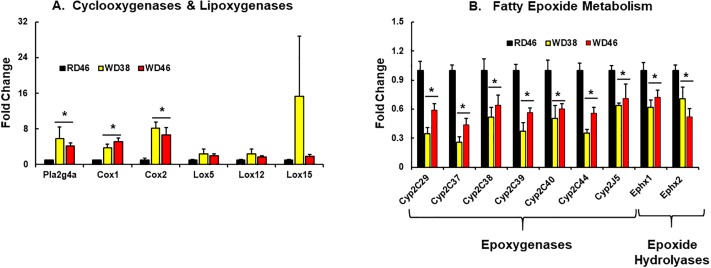
Western diet effects on hepatic expression of enzymes linked to oxylipin metabolism: Cyclooxygenases and lipoxygenases (A) and enzymes involved in fatty epoxide metabolism (B). Transcript abundance was quantified as described above. Results are expressed as mRNA abundance, as fold change; mean ± SEM, N = 7–8 samples, *, FDR <0.05 versus the RD46 group. [A: PLA2g4a, phospholipase A2g4a; Cox, cyclooxygenase; Lox, lipoxygenase]; [B: Cyp2C, cytochrome P450 2C class; Cyp2J, cytochrome P450 2J class; Ephx1, epoxide hydrolase (microsomal); Ephx2, epoxide hydrolase (soluble)].